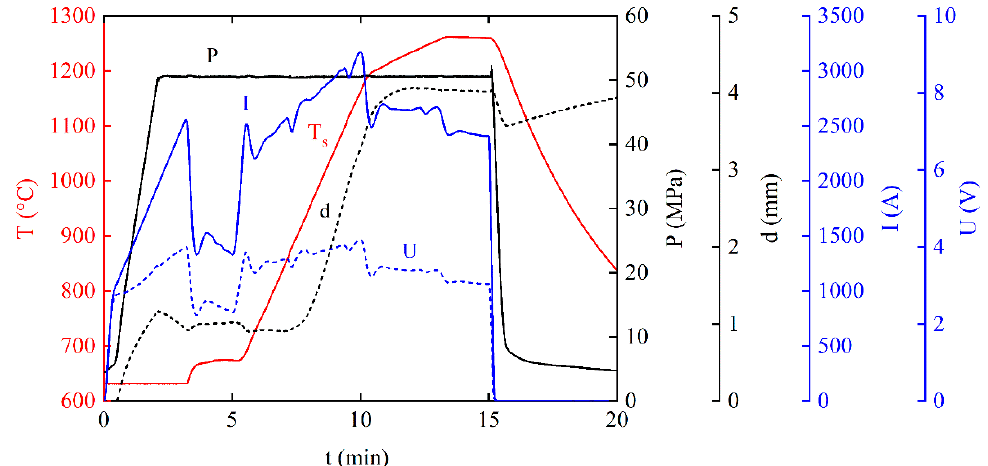
Figure 3. Evolution of the SPS parameters during the processing of a metallic TiAl alloy, in the case of a 36 mm sample (T s : corrected sample temperature, P: applied mechanical pressure, I: intensity, U: voltage and d: sample thickness reduction).